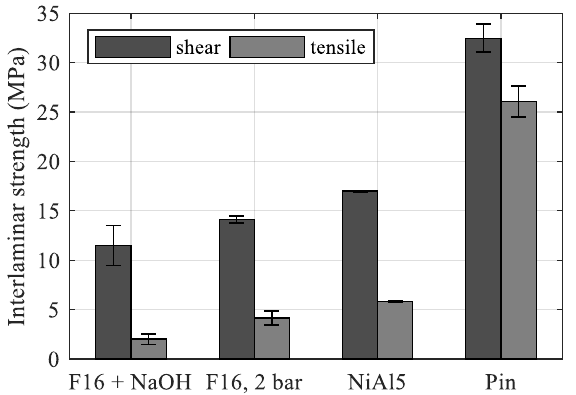
Figure 10. Interlaminar strength of hollow cylinder specimens.